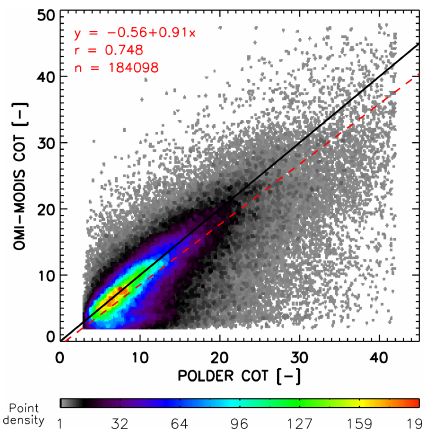
Figure 7. Scatter plot of POLDER COT gridded to the OMI foot- print versus COT from OMI–MODIS data. The red dashed line shows the linear least-squares